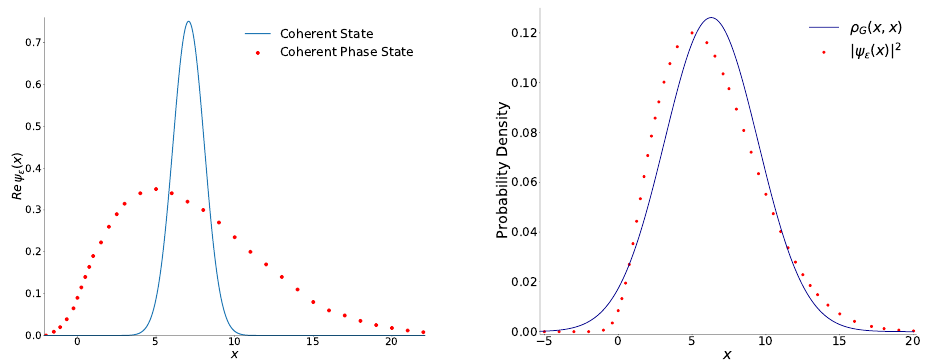
Figure 5. ( Left ) The real wave function ψ ε ( x ) in the case of ϕ = 0 and (cid:104) ˆ n (cid:105) = 25, compared with the coherent state wave function ψ α ( x ) with α = 5. ( Right ) The probability density | ψ ε ( x ) | 2 for ϕ = 0 and (cid:104) ˆ n (cid:105) = 25, compared with the Gaussian probability density (23) with (cid:104) x (cid:105) = 6.3 and σ x = 10. Series (22) was calculated with 10,000 terms.